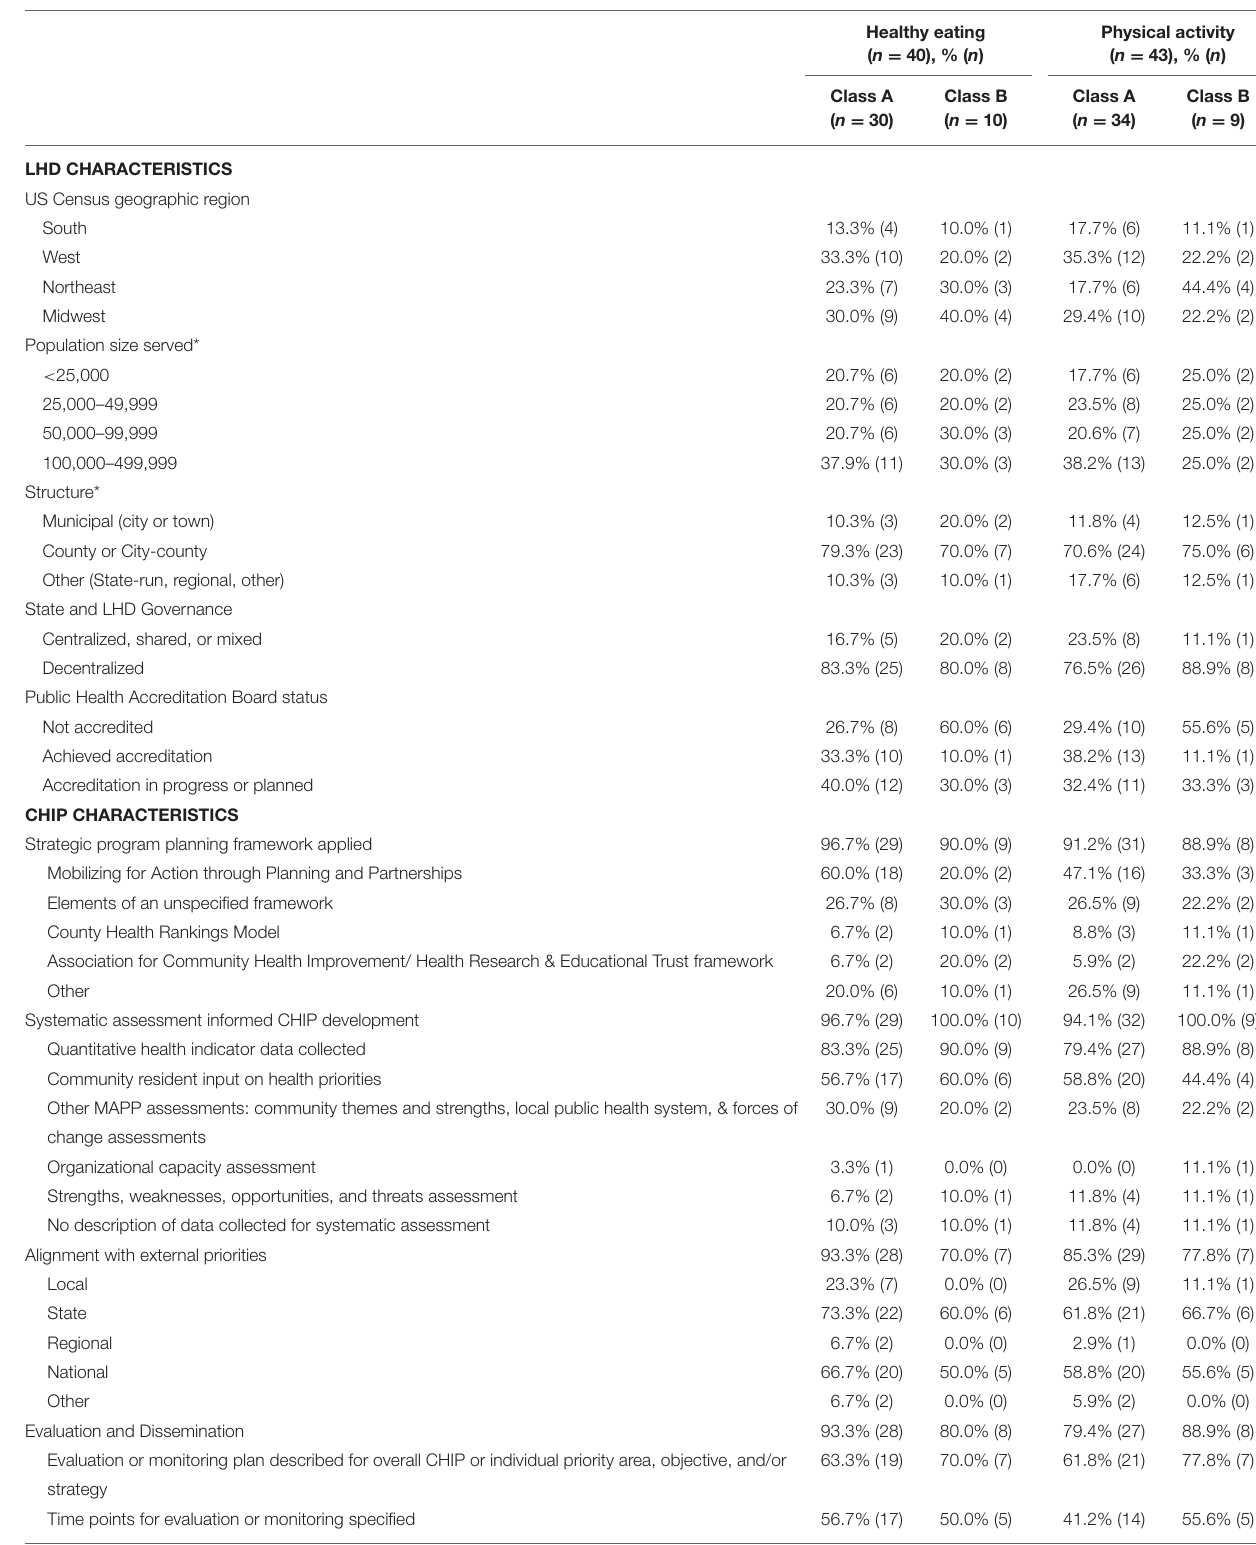
TABLE 4 | Characteristics of study CHIP classes by topic